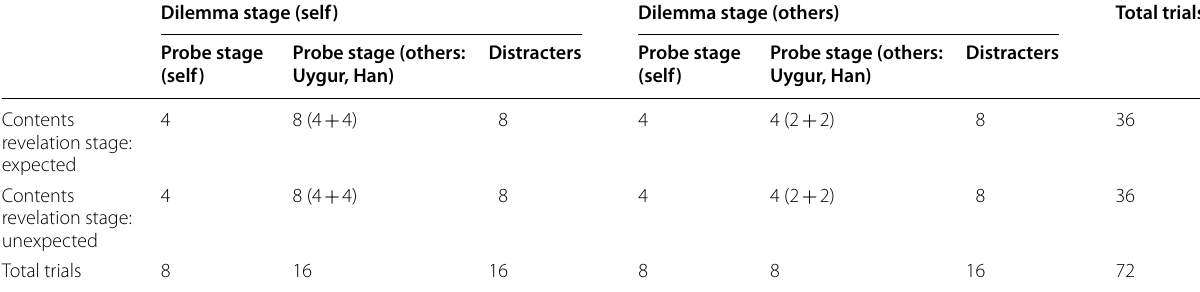
Table 2 Number of trials under different task conditions in self/other differentiation task